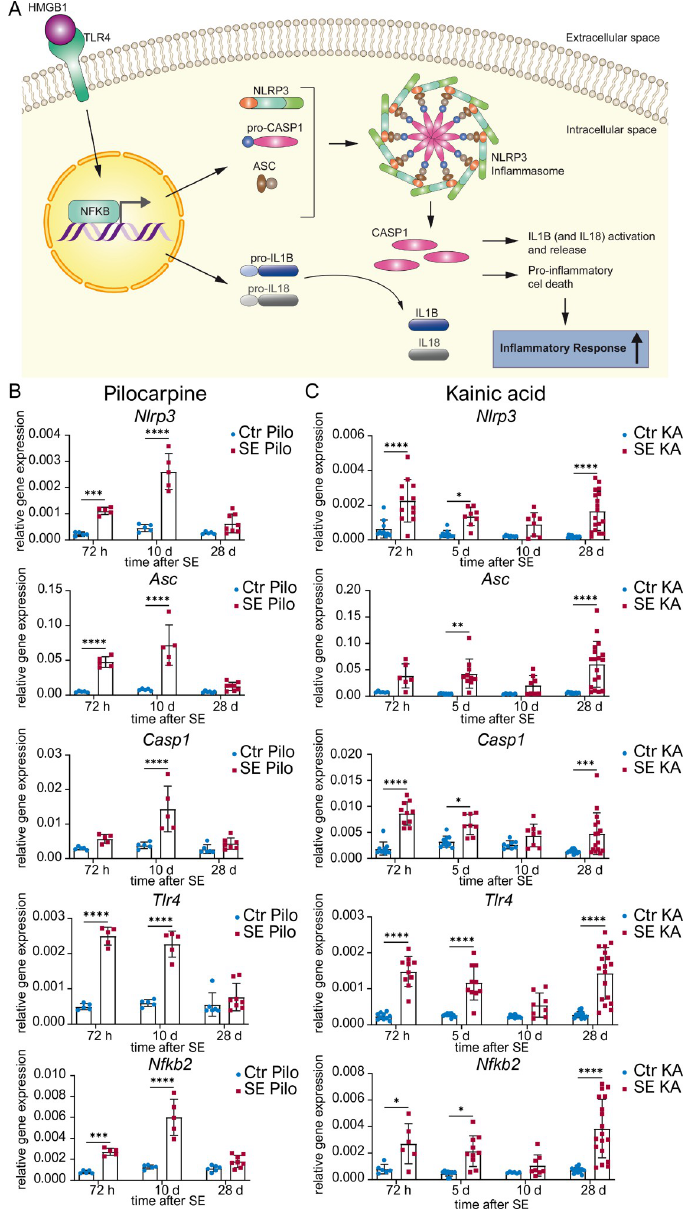
Fig 1. mRNA expression of NLRP3 and associated signalling molecules are differently regulated after SE elicited by pilocarpine or kainic acid. ( A ) Schematic representation of the NLRP3 pathway: After activation of Toll-like receptor (TLR) 4 by High-Mobility-Group-Protein (HMG) B1, nuclear factor ’kappa-light-chain-enhancer’ of activated B-cells (NFKB) 2 is activated and translocates to the nucleus. Here, it enhances transcription of NOD-like receptor protein ( Nlrp ) 3 and Interleukins. Subsequently, NLRP3, Apoptosis-like-speck protein (ASC) and an inactive precursor of cysteine-dependent aspartate-specific Protease (CASP) 1 assemble to form the NLRP3 inflammasome. Upon activation of the inflammasome, pro-CASP1 is cleaved and activated, which then leads to cleavage of interleukin (IL) 1B and 18, as well as proinflammatory cell death. ( B ) Relative mRNA levels ( ΔΔ C t method) of inflammasomal associated genes are analysed 72 h (n � 5), 10 d (n � 5) and 28 d (n � 6) after pilocarpine-induced status epilepticus (SE Pilo) as well as ( C ) 72 h (n � 4), 5 d (n � 5), 10 d (n � 4) and 28 d (n � 6) after kainic acid-induced SE in hippocampal CA1 (SE KA) compared to non-SE controls (Ctr Pilo/Ctr KA). Relative mRNA levels of NOD-like receptor protein ( Nlrp ) 3 and other inflammasomal associated genes such as Asc , Casp1 , Tlr4 , and Nfkb2 are quantified with ΔΔ C t method normalized to the ubiquitously expressed (encoding proteins that are required for all cell types) housekeeping gene β -actin after SE. Data is shown as mean ± SD and analysed with 2way ANOVA followed by Sidak’s post hoc test. Asterisks indicate significant differences between groups (control vs. SE): � p < 0.05, �� p < 0.01, ��� p < 0.001, ���� p < 0.0001. Detailed statistical values are found in S2 Table . https://doi.org/10.1371/journal.pone.0271995.g001 PLOS ONE | https://doi.org/10.1371/journal.pone.0271995 August 16,